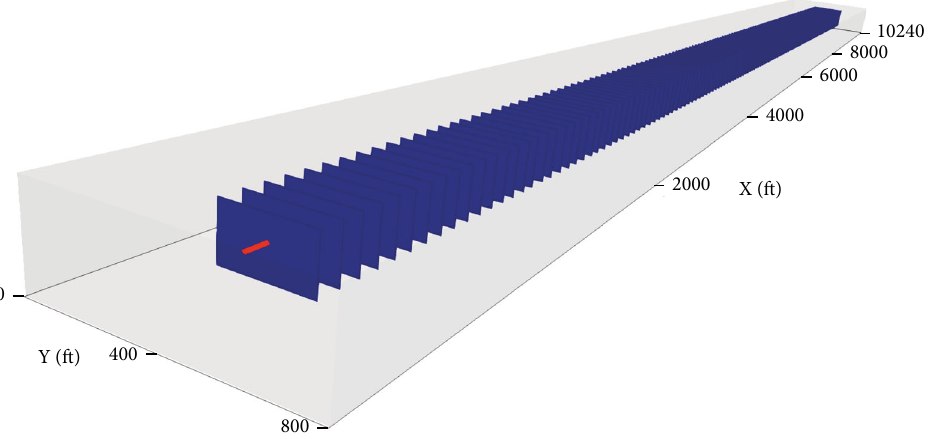
Figure 3: A tight oil reservoir model including a horizontal well with multistage hydraulic fractures. The red line represents wellbore, and the blue rectangle represents hydraulic